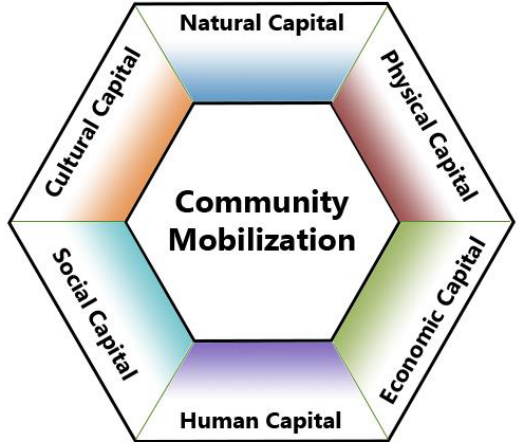
Figure 1. Community Capital: A Framework for Sustainable Community Development. Sustainable development requires mobilizing citizens and their governments to strengthen all forms of community capital. Community mobilisation is necessary to coordinate, balance and catalyze community capital. Source: [9].